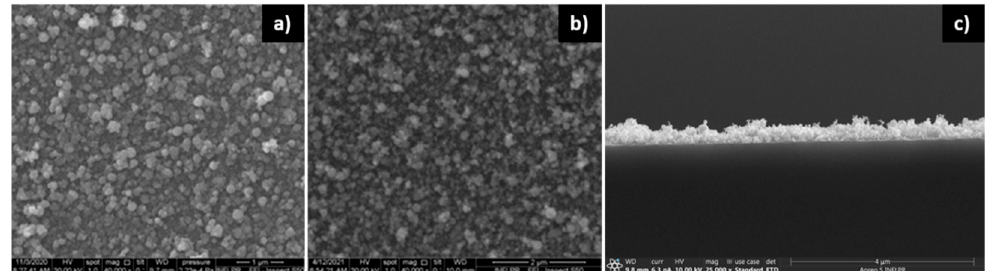
Figure 7. Pd thin films deposited at 10 kHz in 30’ using the 532 nm laser radiation of a ps laser, and an average power of 0.2 W. ( a ) in 100 mTorr Ar; ( b ) in 700 mTorr Ar; ( c ) cross-section of film deposited in 700 mTorr Ar.